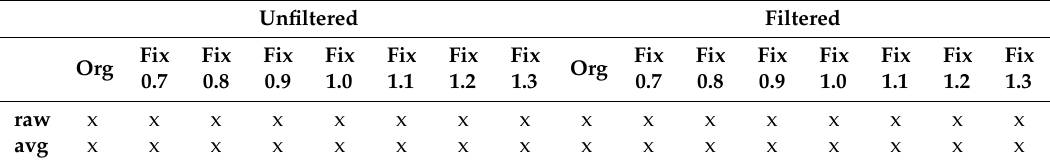
Table 3. Overview of the data sets and processing steps considered in the